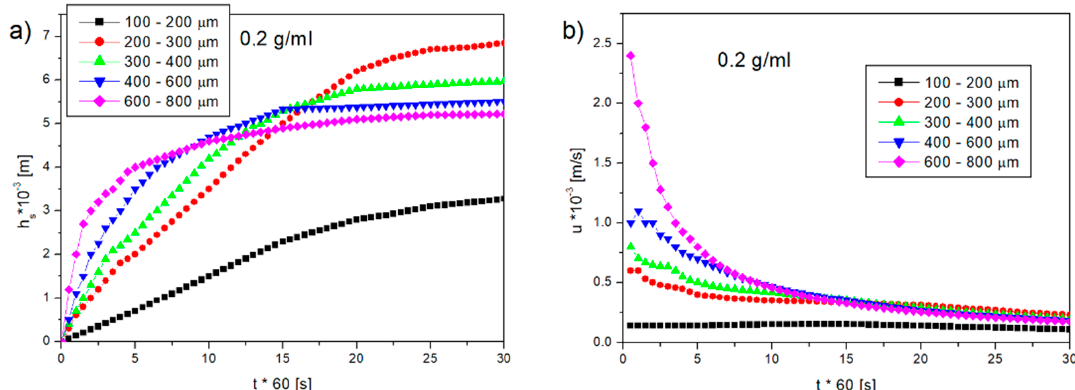
Figure 6. Dependence plot of ( a ) sediment layer height and ( b ) sedimentation velocity during the process for the sedimentation of microspheres with a concentration of 0.2 g/mL in an 70% emulsion, d e1 .